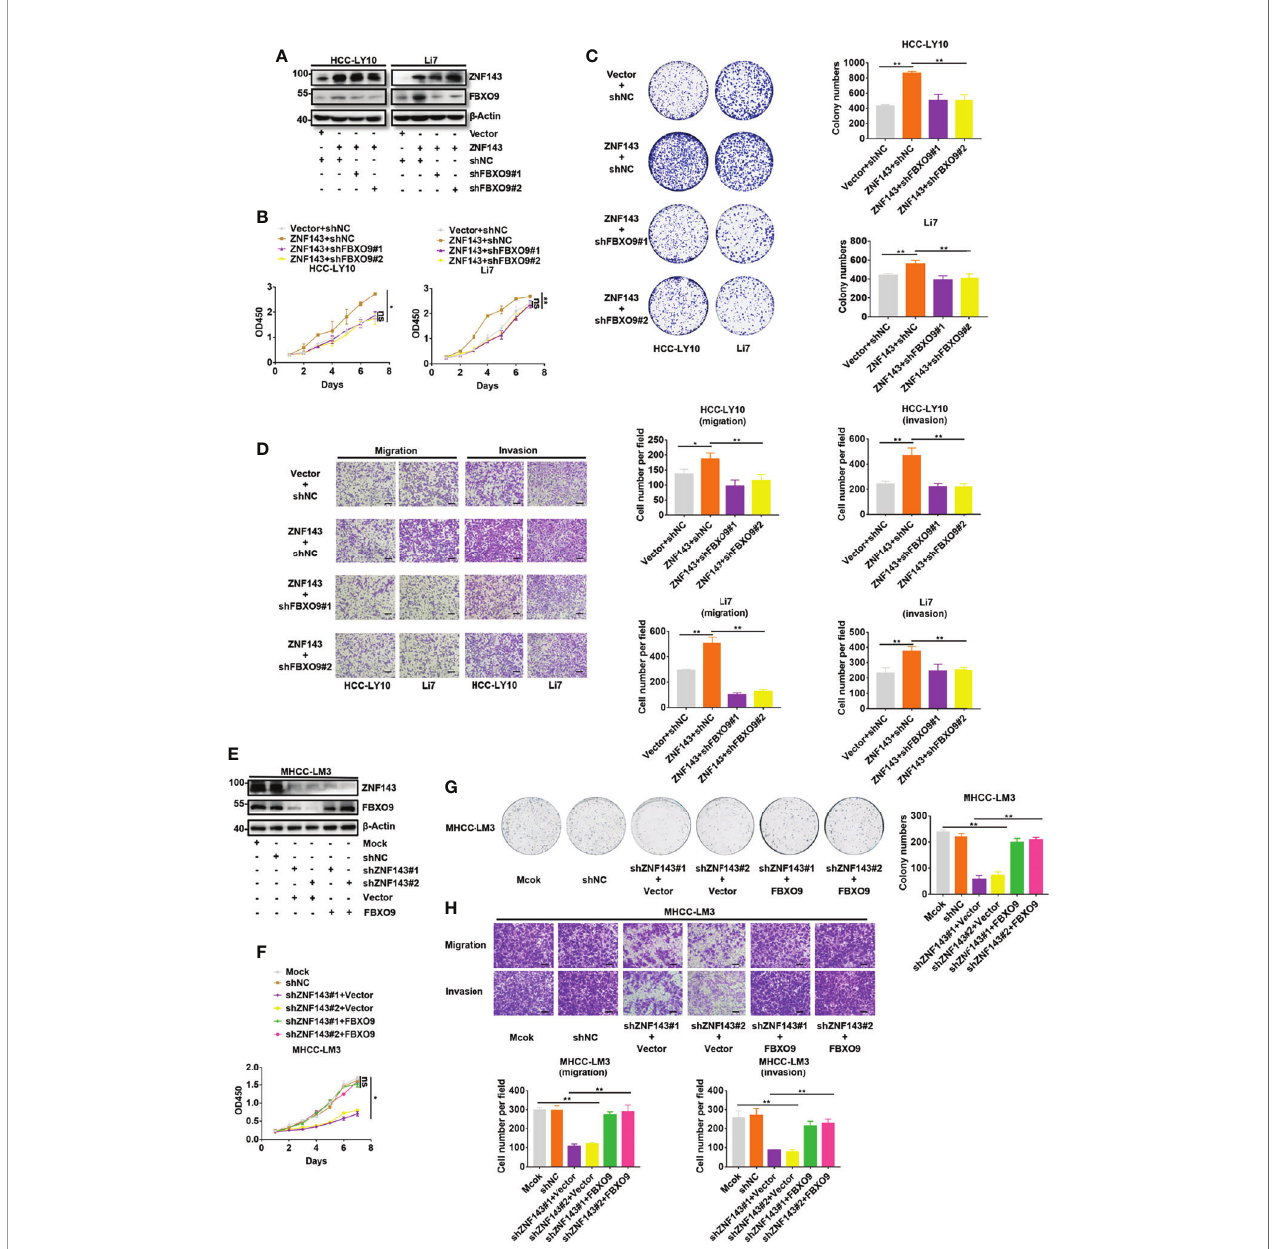
FIGURE 4 | ZNF143 promotes HCC cell growth and mobility by enhancing FBXO9 expression. (A) ZNF143-overexpressing HCC cells were transfected with shNC or shFBXO9, and the knockdown ef fi ciency of FBXO9 was tested by western blotting. (B, C) The effects of FBXO9 silencing on ZNF143-induced cell growth in Li7 and HCC-LY10 cells were measured by CCK-8 and in vitro colony formation assays. (D) Transwell assays of cell migration and invasion in ZNF143-overexpressing HCC cells treated with shFBXO9. (E) FBXO9 plasmid was transfected into ZNF143 knockdown HCC cells, and the protein expression levels of FBXO9 and ZNF143 were detected using western blotting. (F, G) Effects of FBXO9 overexpression on the proliferation of ZNF143 knockdown HCC cells were measured by CCK-8 and colony formation assays. (H) Transwell assays of cell migration and invasion in ZNF143 knockdown HCC cells treated with FBXO9 plasmid. Data are shown as mean ± S.D, n = 3. Scale bars: 100 m m. *, P < 0.05; **, P < 0.01; ns, no signi fi cance, by two-tailed Student ’ s t -test or one-way